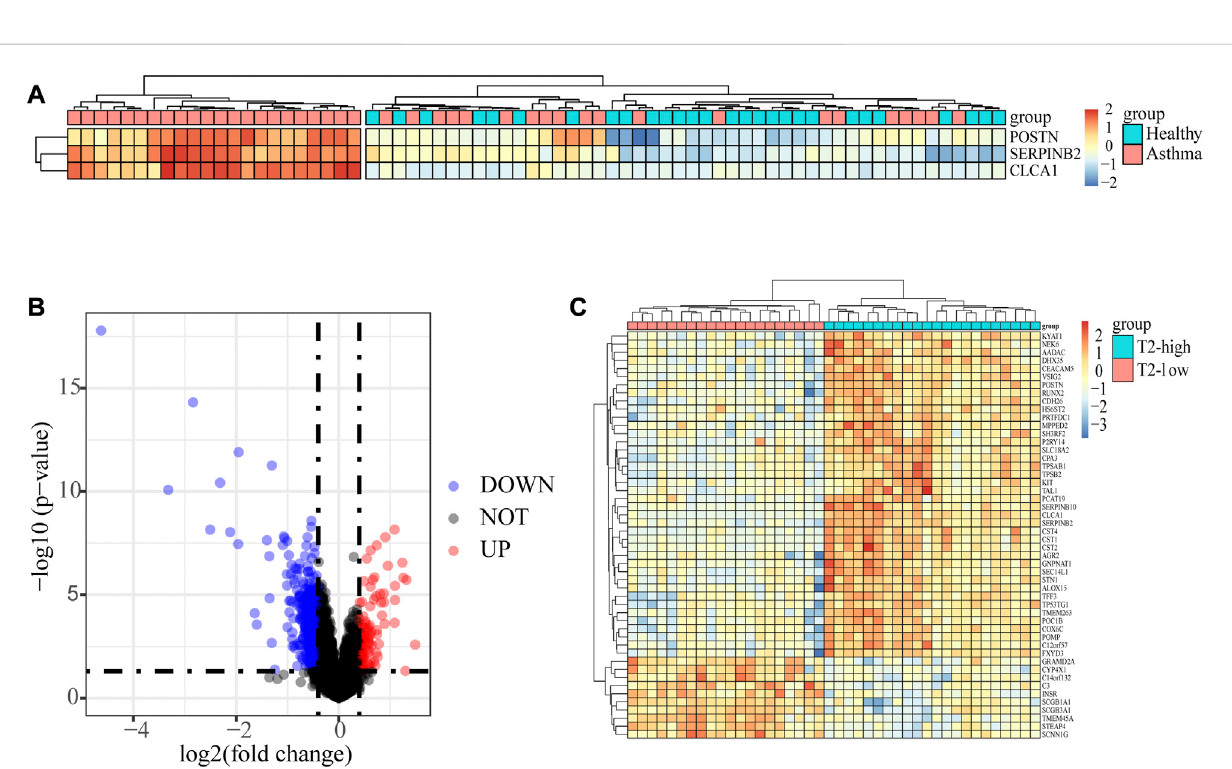
FIGURE 1 Identi fi cation of the epithelial DEGs between T2-low and T2-high asthma. (A) Heatmap showing unsupervised hierarchical clustering of POSTN, SERPINB2, and CLCA1 expression levels in bronchial epithelium (red represents a high expression level, and blue represents a low expression level); (B) VolcanoplotshowingDEGsinT2-lowvs.T2-highasthma; (C) HeatmapofTop50increasedanddecreasedDEGs(redrepresentsahighexpressionlevel, and blue represents a low expression